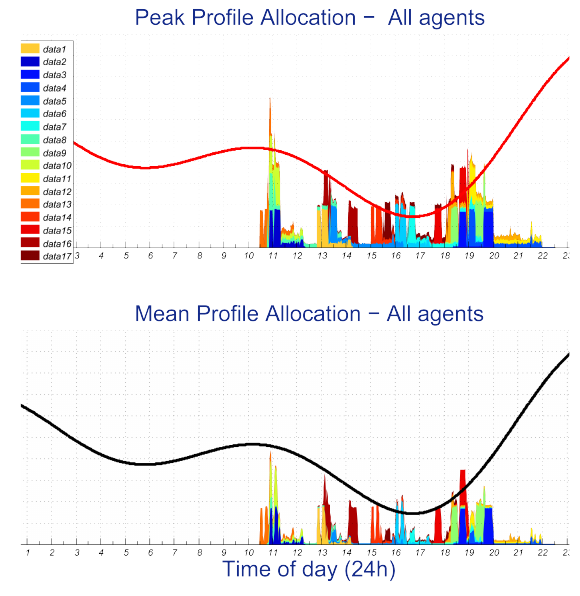
Figure 3. The peak (upper plot) and mean (lower plot) power load (Watts) of a 5 agents neighborhood is displayed at the last iteration ( t = 10 ) of the distributed algorithm proposed in Section 2. The red (black) curve represents the district global load we aim to attain. All agents are flexible during 10 am-9 pm.